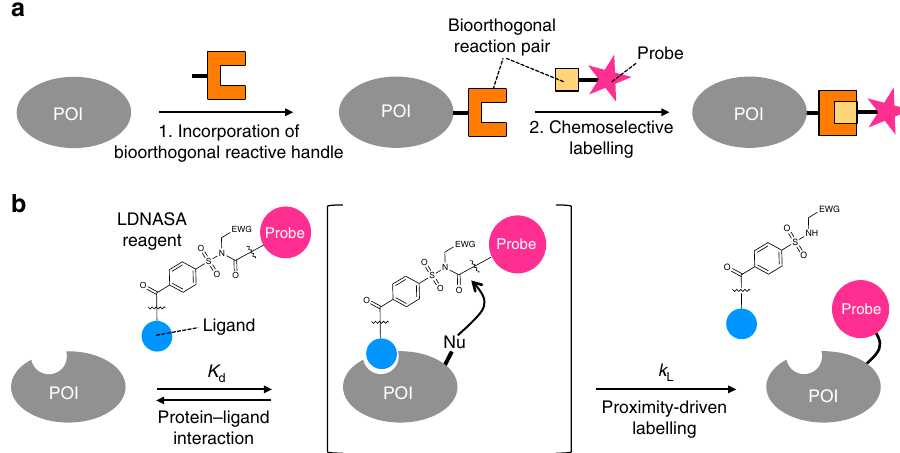
Fig. 1 Two distinct approaches for bioorthogonal protein labelling. a Schematic illustration of protein labelling through bioorthogonal chemistry. The fi rst step involves the genetic incorporation of a bioorthogonal reactive handle into a protein of interest (POI) in cells. In a second step, the reactive handle chemoselectively reacts with a designed synthetic probe. b Schematic illustration of the basic principle of ligand-directed N -acyl- N -alkyl sulfonamide (LDNASA) chemistry. The reagent binds to a POI through a speci fi c protein – ligand interaction, driving a chemical reaction between the reactive group and a natural nucleophilic amino acid located on the protein surface, through the proximity effect. EWG, electron-withdrawing group; K d , dissociation constant; k fi rst-order rate constant for the labelling process; Nu, nucleophilic amino L ,